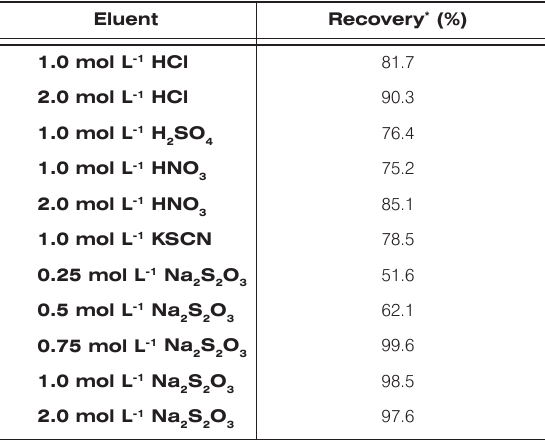
Table 1. Effect of type and concentration of eluent on the recovery of palladium.